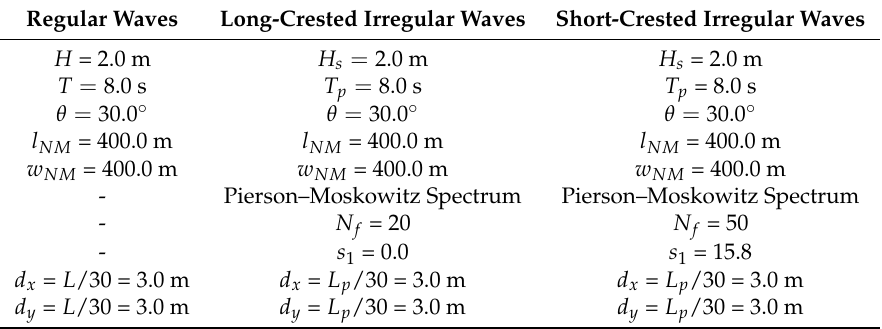
Table 2. NEMOH simulation parameters for the MILDwave-NEMOH coupled model. Regular Waves Long-Crested Irregular Waves